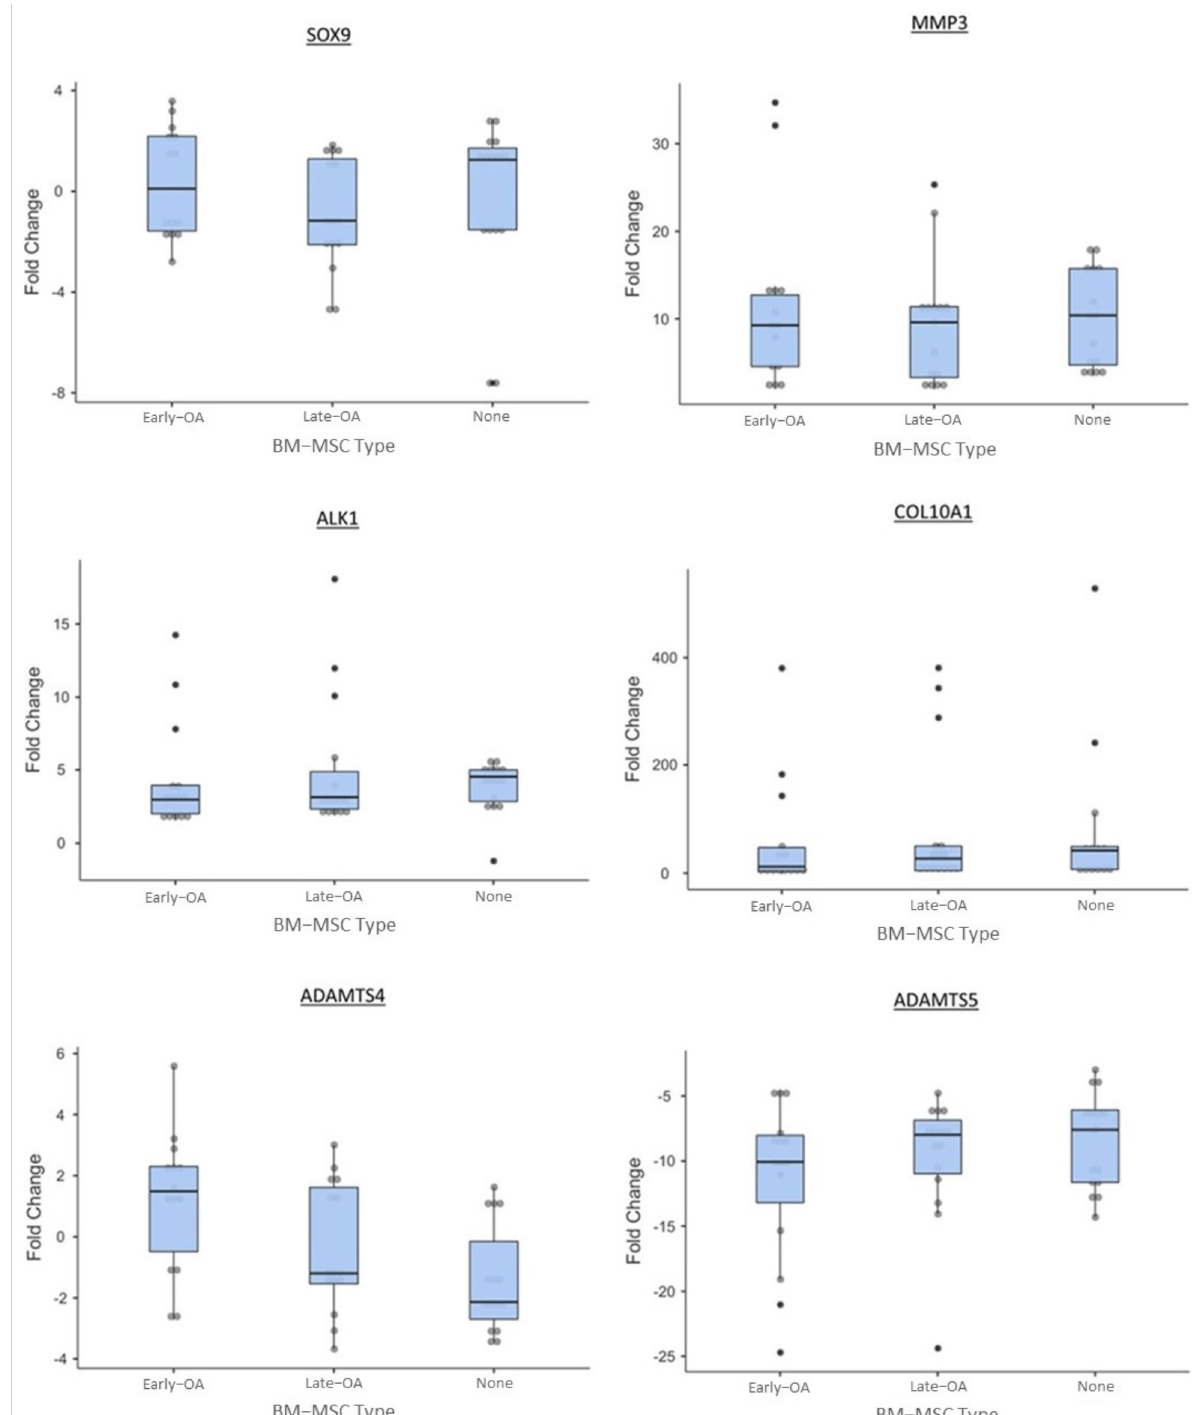
Figure 12. Relative fold change of additional genes of interest between day 0 and day 21 of the co-culture. Error bars represent the standard error of the mean. Significant differences are indicated by horizontal